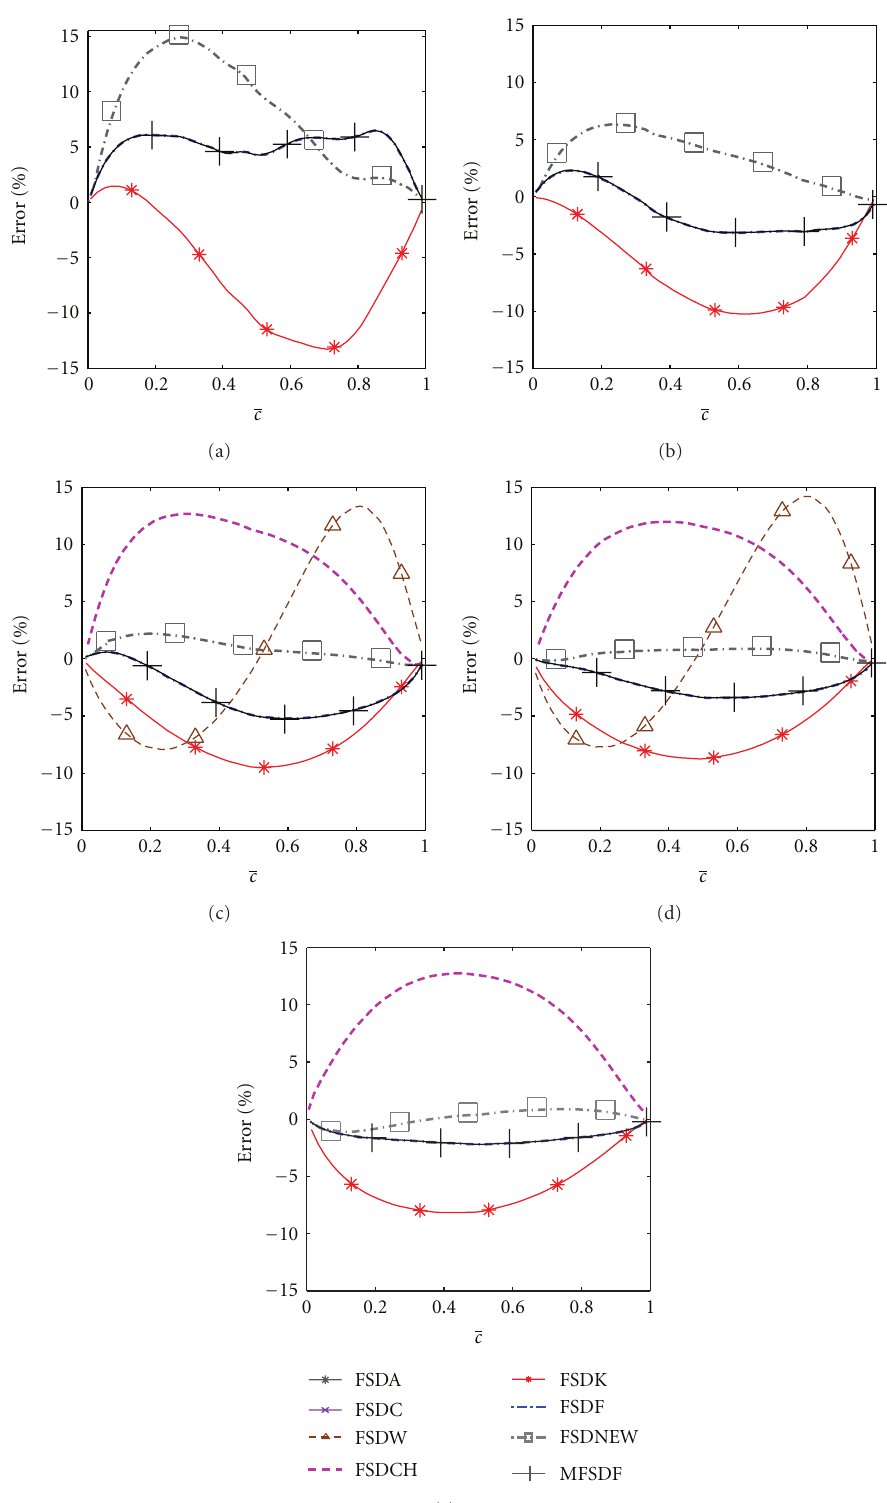
Figure 7: Variation of percentage error (17) on c across the flame brush for Δ = 24 Δ m = 2 . 4 δ th according to FSDA, FSDC, FSDW, FSDCH, FSDK, FSDF, FSDNEW, and MFSDF predictions for (a–e) cases